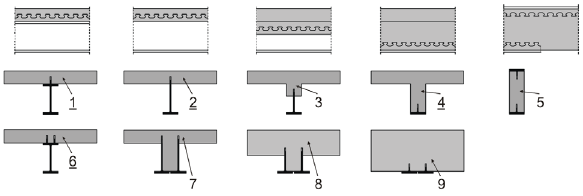
Figure 1: Different side views (upper row) and cross sections (middle and bottom rows) of girders with composite dowels. 1–5: With single dowel strip, 6–9: sections using two dowel strips [4].